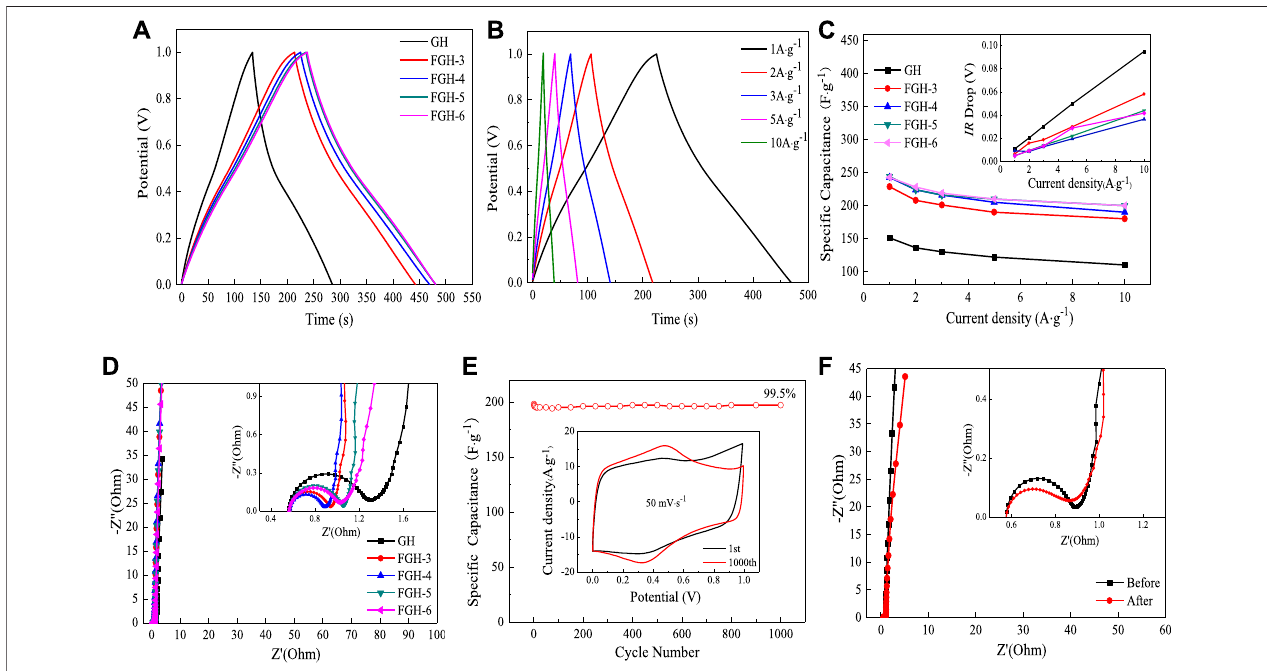
FIGURE 6 | (A) GCD curves of the different samples at a current density of 1 A/g, (B) GCD curves of FGH-4 at different current densities, (C) gravimetric speci fi c capacitanceandIRdropcurves(inset)ofdifferentsamplesatdifferentcurrentdensities, (D) EIScurvesofdifferentsamplesin1 MH 2 SO 4 , (E) cycleperformanceandCV split graph at a scan rate of 50 mV/s (inset) for FGH-4, and (F) EIS curves of FGH-4 before and after 1,000